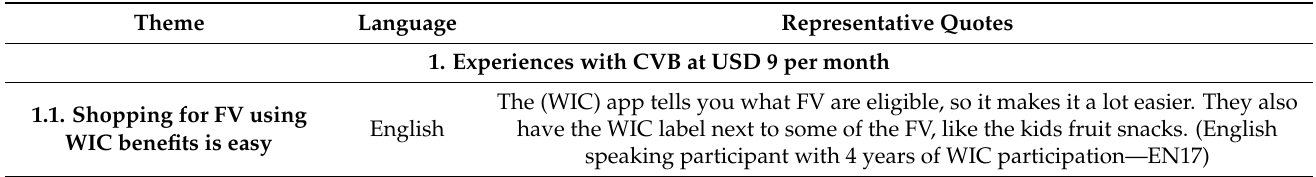
Table 2. Emergent themes for (A) experiences with CVB at USD 9 per month, (B) experiences after CVB increase to USD 35 per month, (C) other changes on spending outside of WIC benefits with CVB increase to USD 35 per month, (D) impacts of USD 35 per month CVB increase on dietary intakes and (E) experiences after CVB change to USD 24 per month 1